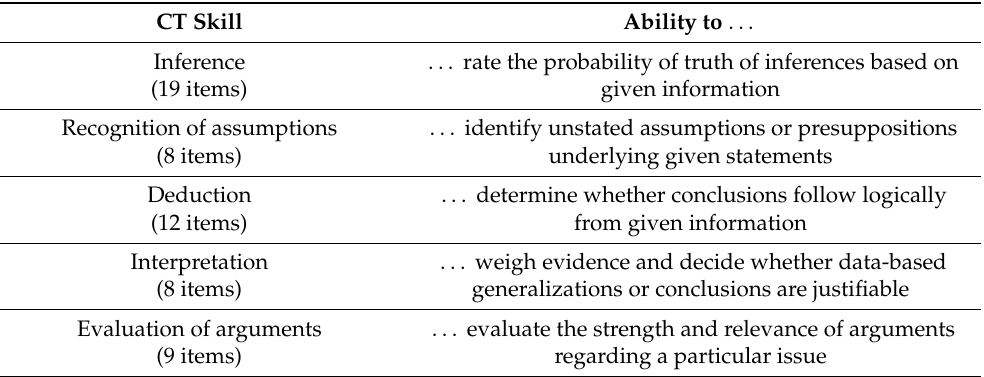
Table 1. CT skills covered by the WGCTA. CT Skill Ability to . .